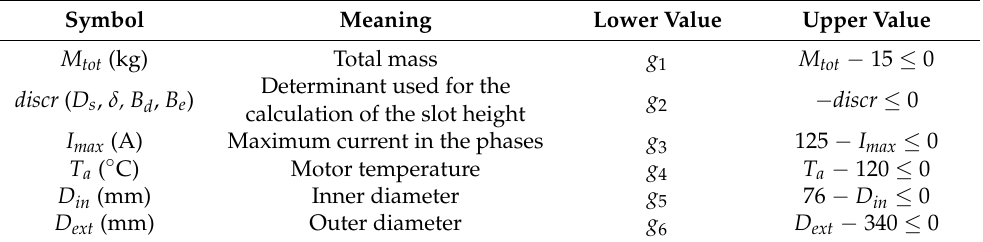
Table 2. Inequality constraints g i , where i = 1, . . . , nc in the brushless DC motor